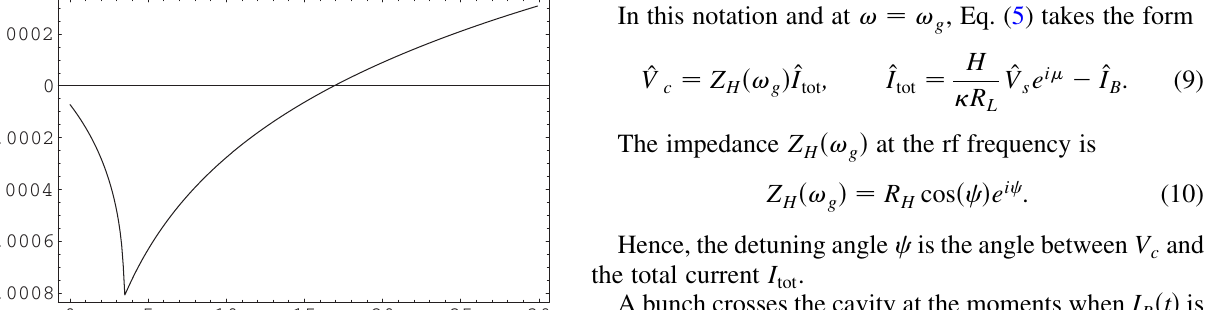
FIG. 2. Imaginary part of the poles of V the FB gain H . The FB is stable if the imaginary part shown in the plot is